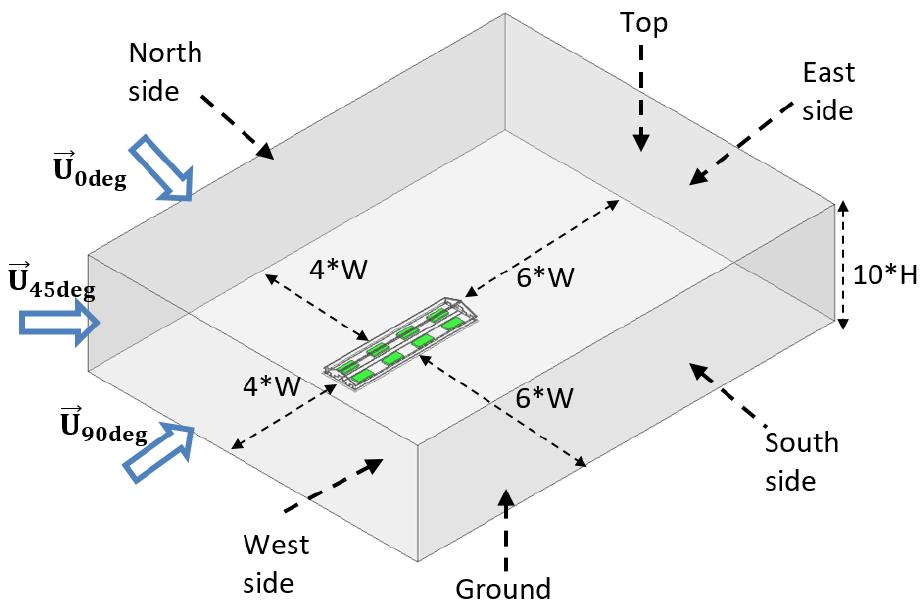
Figure 1. Numerical domain dimensions and boundary conditions, example for the barn L / W = 4, total open (see Section 2.2 for the chosen